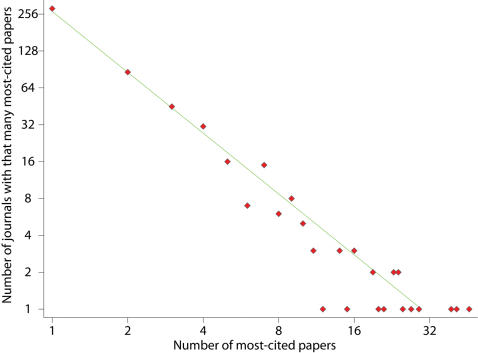
Number of journals that have published different numbers of papers that have been among the 100 most-cited in a scientific field in the last decade.R2 is 0.97 in regression weighted by the number of journals (R2 = 0.92 in unweighted regression, regression coefficients are similar).The graph does not show outlying Science and Nature.